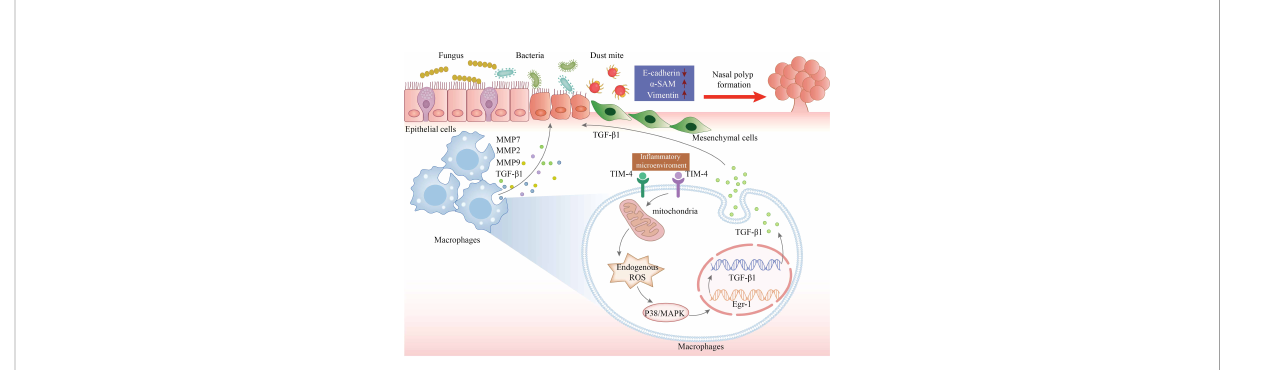
FIGURE 8 The schematic model for TIM-4 in macrophages mediates TGF- b 1 secretion via the ROS/p38 MAPK/Egr-1 pathway to regulate nasal polyp formation. The increased production of TIM-4 in macrophages is stimulated by in fl ammatory microenvironment of CRSwNP. TIM-4 boosts the activity of the secondary messenger ROS. The activation of ROS promotes P38 MAPK phosphorylation and then increases the transcriptional activity of Egr-1. The cascade increases the transcription and translation of TGF- b 1 in macrophages, resulting in an increase of TGF- b 1 secretion, which culminates in promoted EMT in nasal epithelial cells. In conclusion, both increased accumulation of macrophages and increased TIM-4 production by macrophages may result in ROS-dependent activation of p38/MAPK/Egr-1 cascade, which contributes to nasal polyp